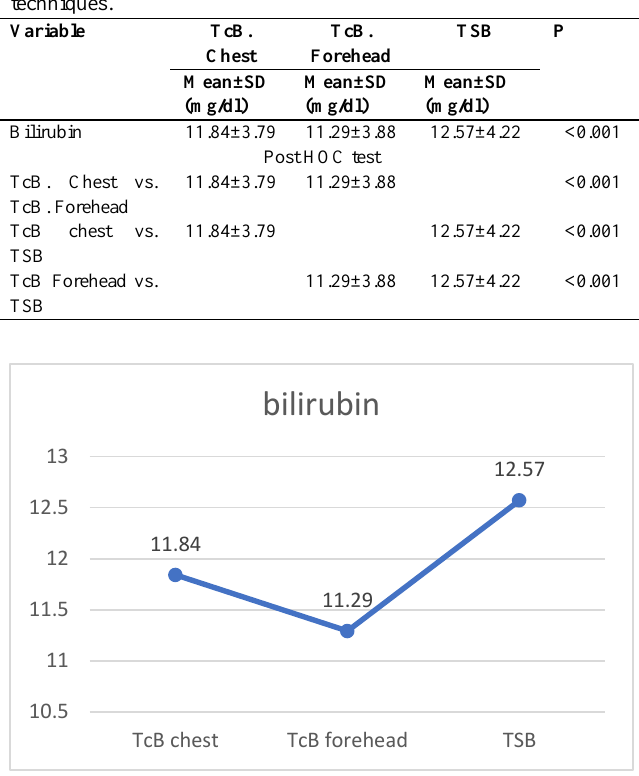
Figure (2) : Distribution of bilirubin level according to different techniques There was a significant positive correlation between TcB on chest, TcB on forehead and TSB as shown in table 6. Table (6): correlation of bilirubin level among different